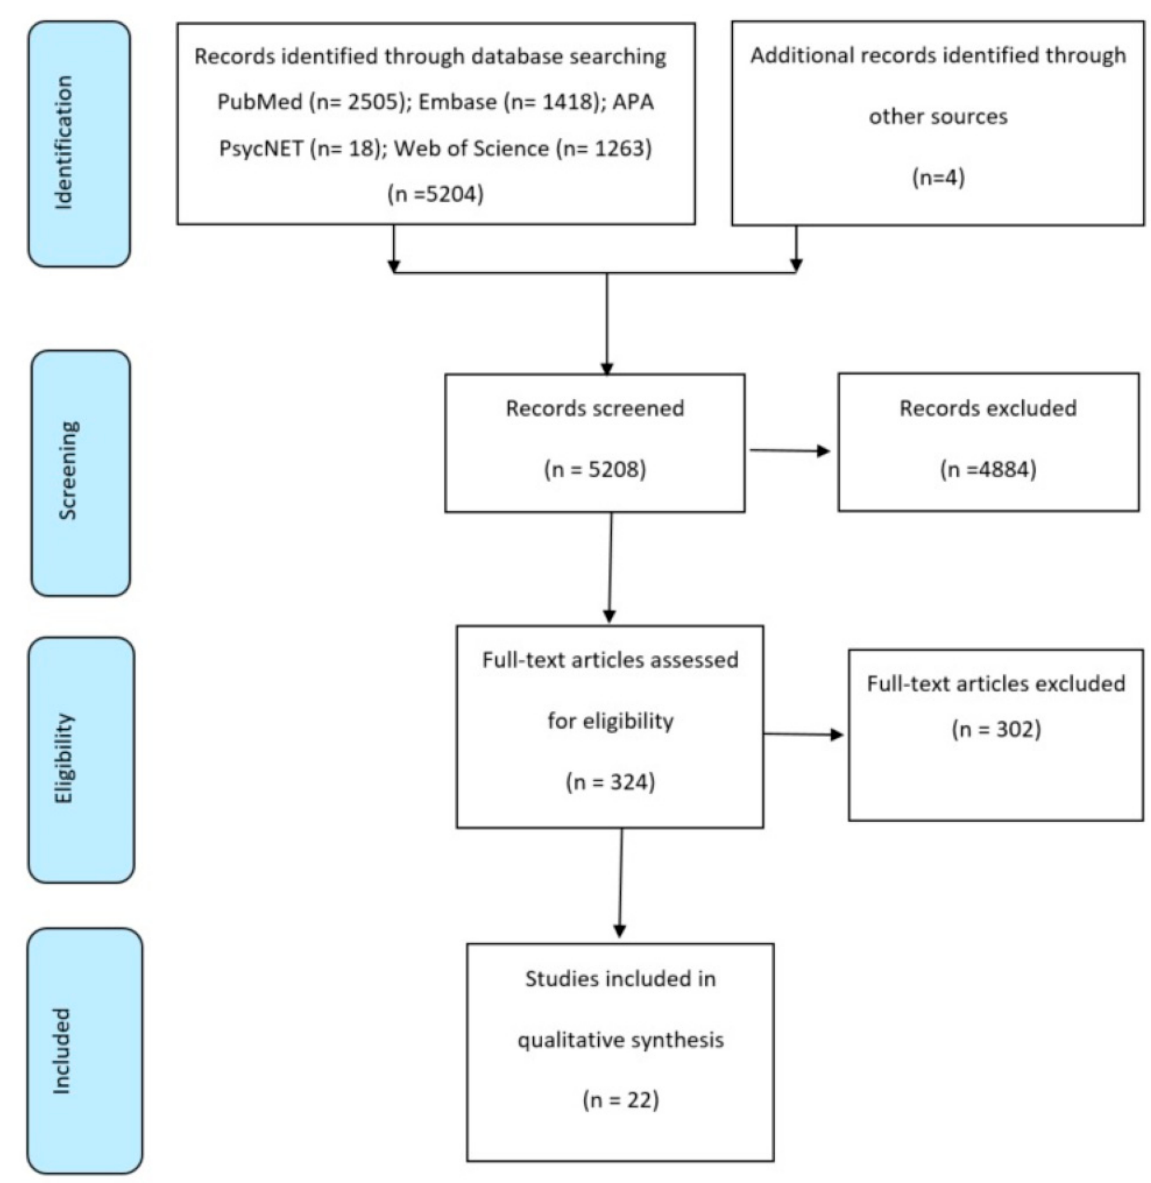
Figure 1. PRISMA flow diagram for trials included and excluded from the systematic review [15].